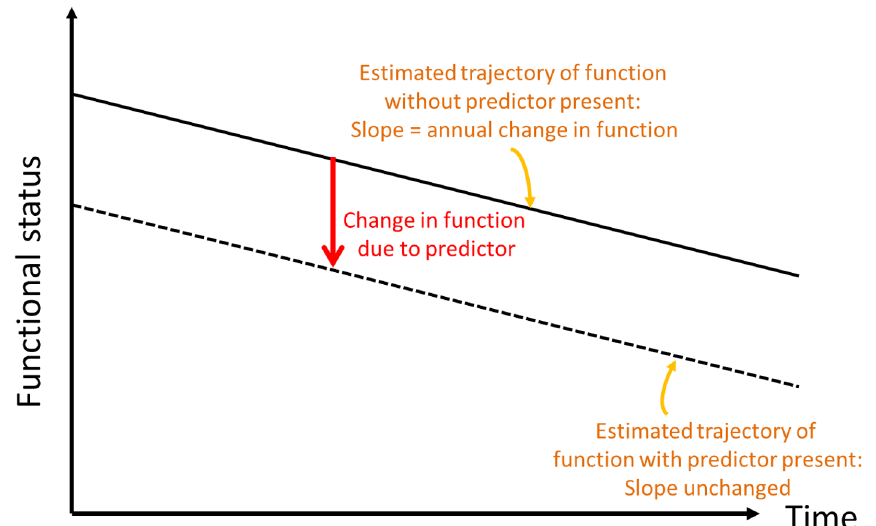
Fig 1. Conceptual depiction of change in baseline functional